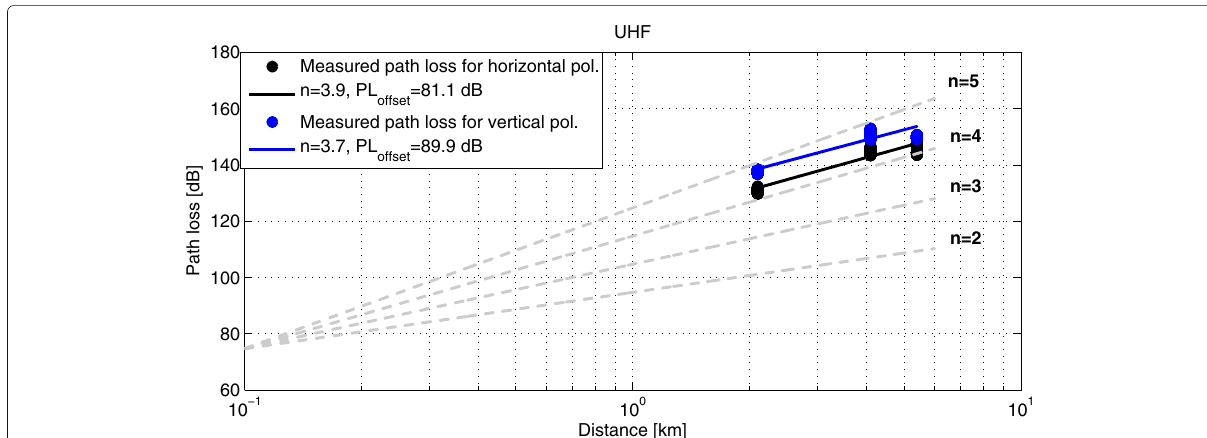
Fig. 7 The measured path loss for 1.3GHz center frequency of the outdoor non-line of sight environment. The black and blue circles represent the measured non-line of sight path loss values for horizontal and vertical co-polarization, respectively